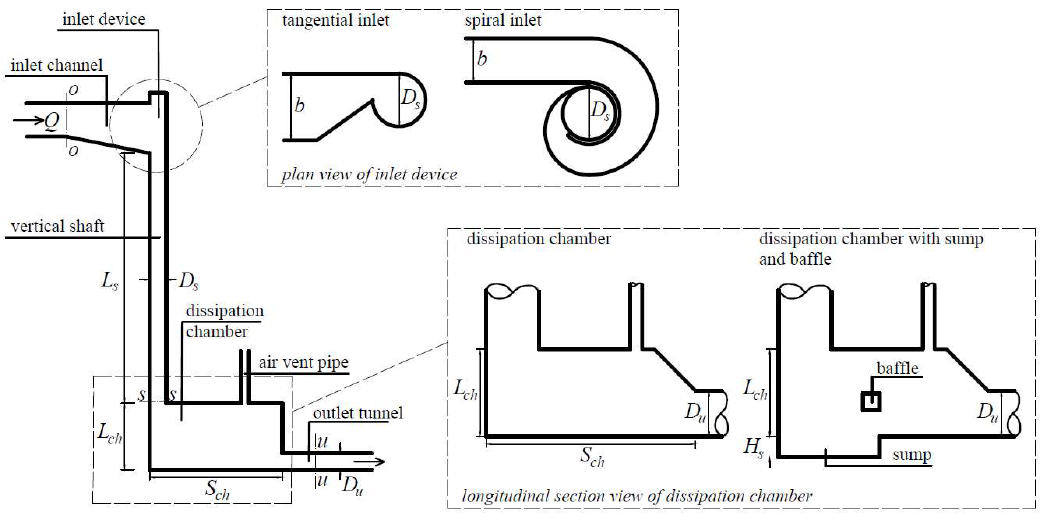
Figure 1. Geometry of vortex drop shafts with detail of tangential and spiral inlets and the dissipation chamber. Note that the represented sketch reports a circular outlet tunnel.